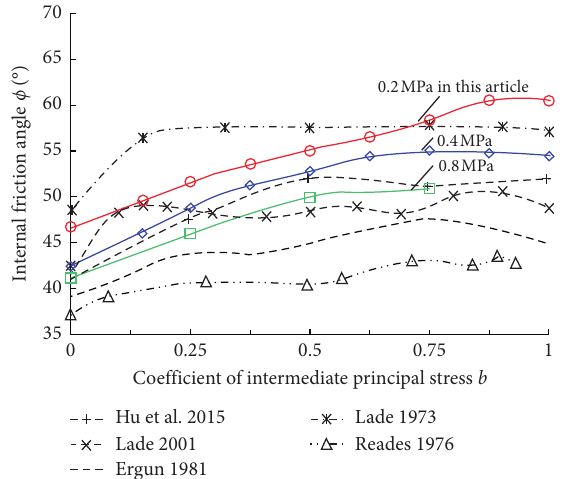
Figure 15: Comparative analyses on the tested internal friction